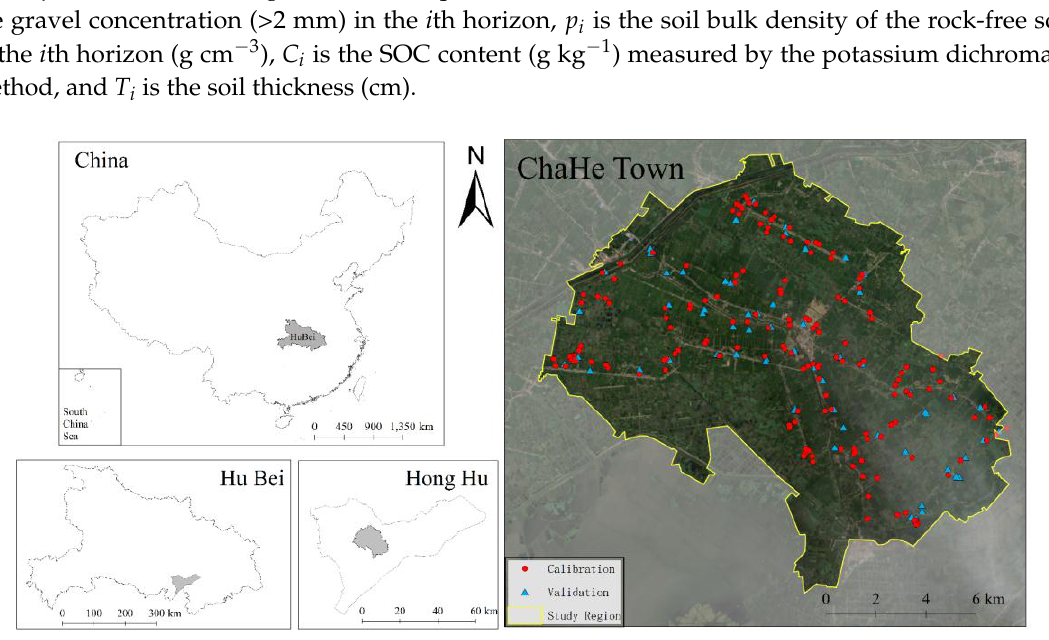
Figure 1. The spatial distribution of the soil samples in the study area.